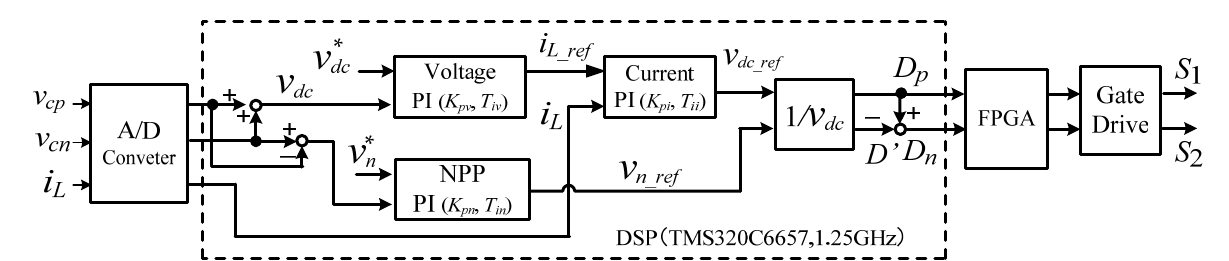
Figure 6. Configuration of parallel circuit with PI controller.